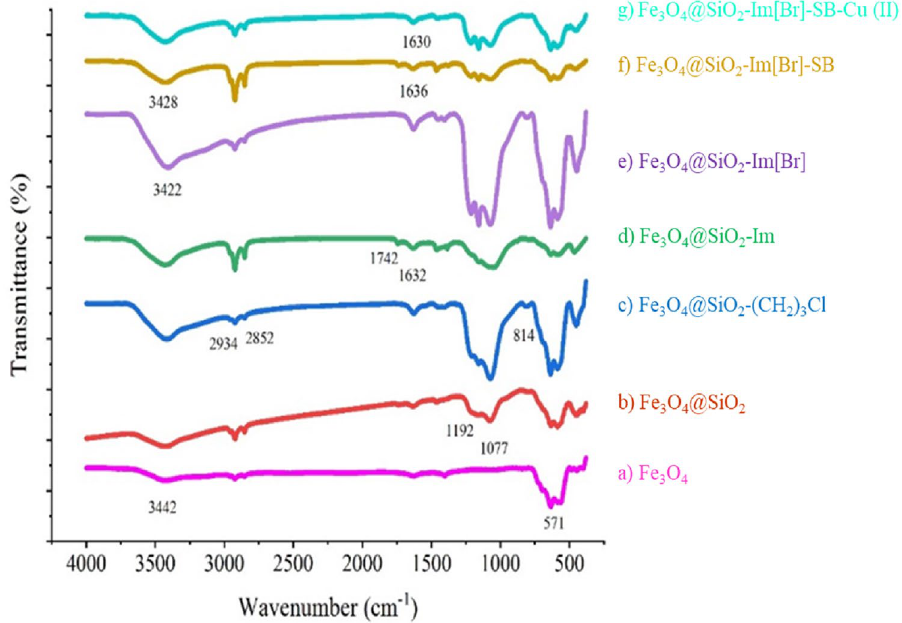
Figure 3. FT-IR spectra: ( a ) Fe 3 O 4 ; ( b ) Fe 3 O 4 @SiO 2 ; ( c ) Fe 3 O 4 @SiO 2 -(CH 2 ) 3 Cl; ( d ) Fe 3 O 4 @SiO 2 -Im; ( e ) Fe 3 O 4 @ SiO